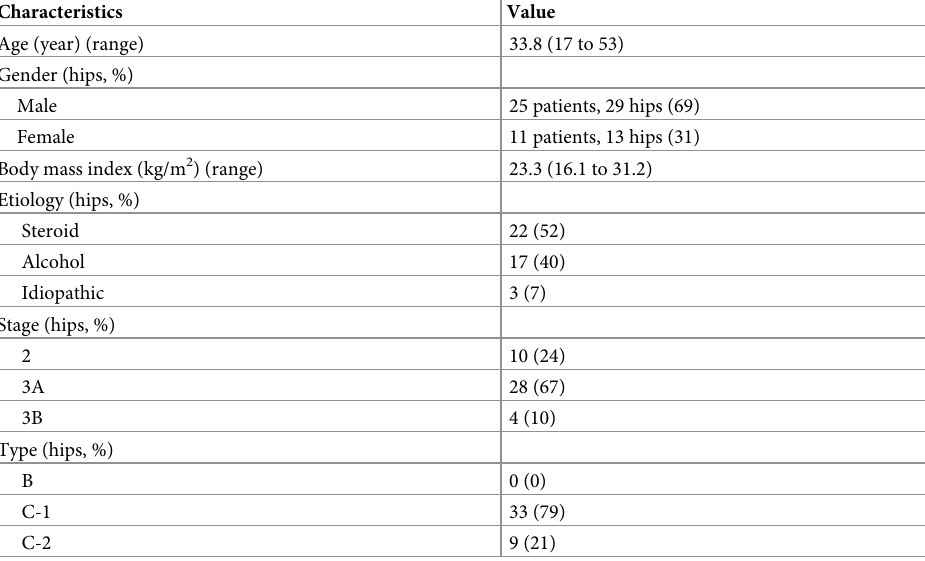
Table 1. Patient